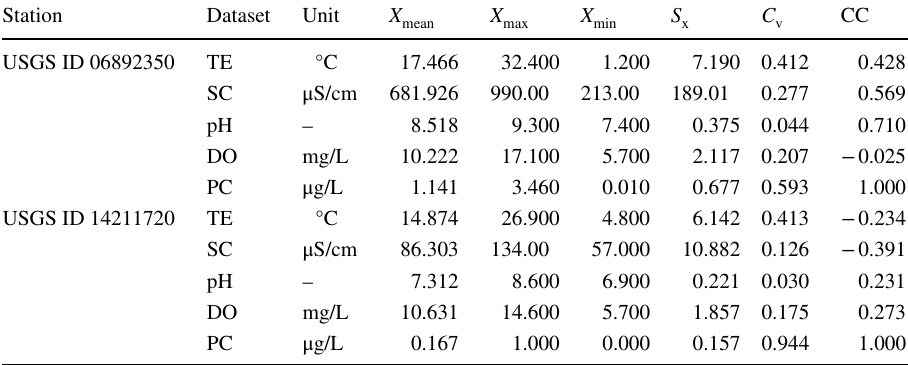
Table 2 Statistical parameters of dataset